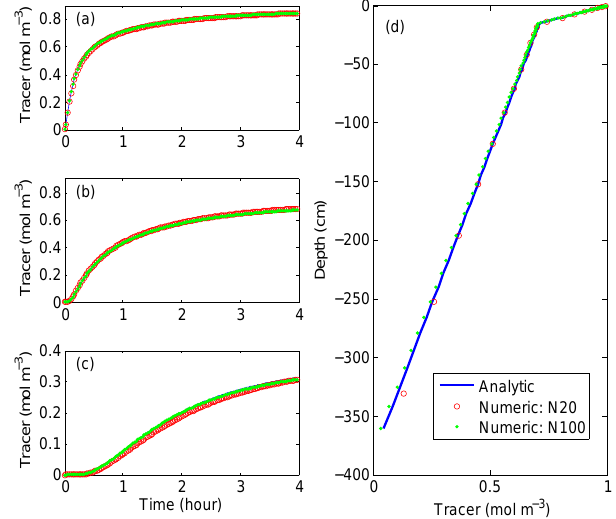
Figure 4. Comparison between the numerical and analytical solu- tions for the point source tracer diffusion model: (a) temporal evolu- tion of tracer concentration at 7cm; (b) temporal evolution of tracer concentration at 15cm; (c) temporal evolution of tracer concentra- tion at 200cm; and (d) steady-state solution. N20 indicates the so- lution using 20 numerical layers and N100 indicates the solution using 100 numerical